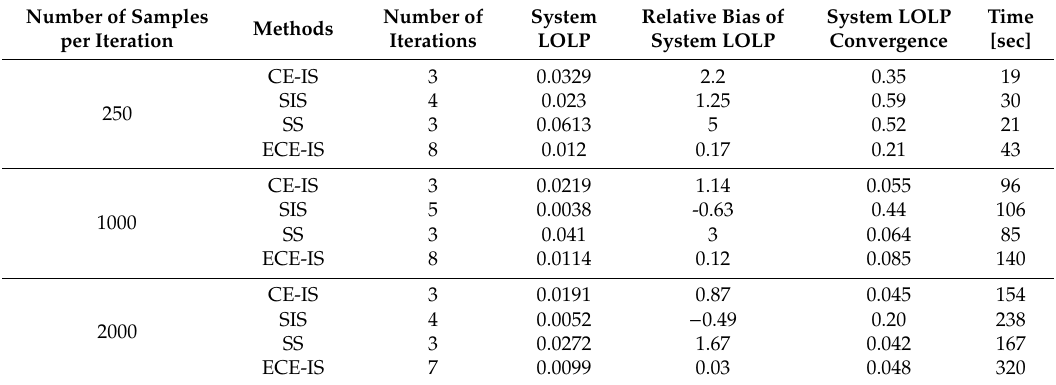
Table 2. Methods comparison for di ff erent numbers of samples.